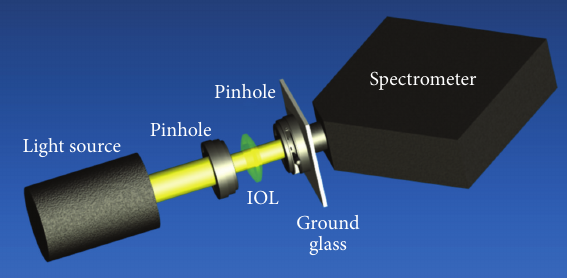
Figure 1: Setup for determining transmittance properties.